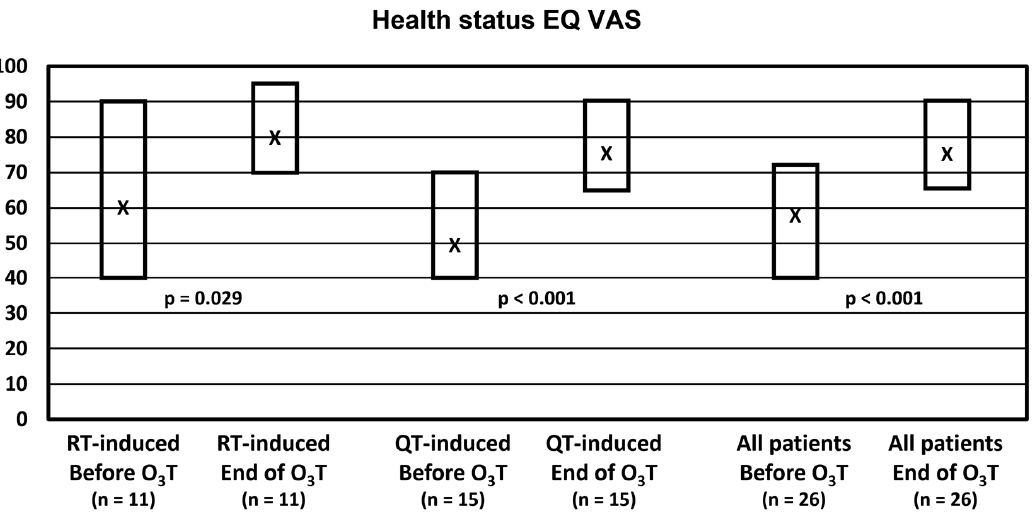
Figure 1. Self-reported health status in the visual analog scale (EQ VAS). X: median value. Box: quartiles 1 and 3.